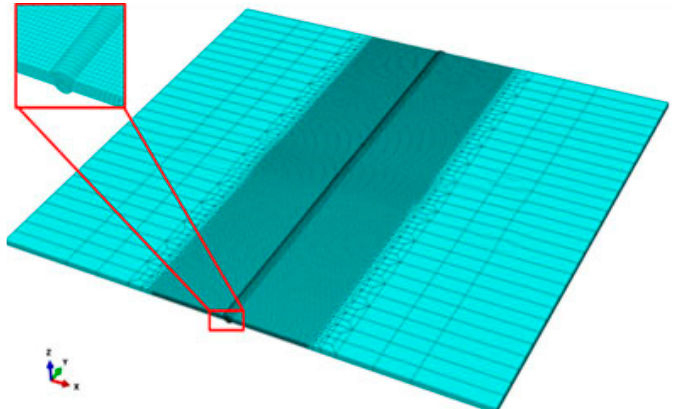
Figure 8. Finite element of the fully adopted mesh for all thermal and mechanical analysis.